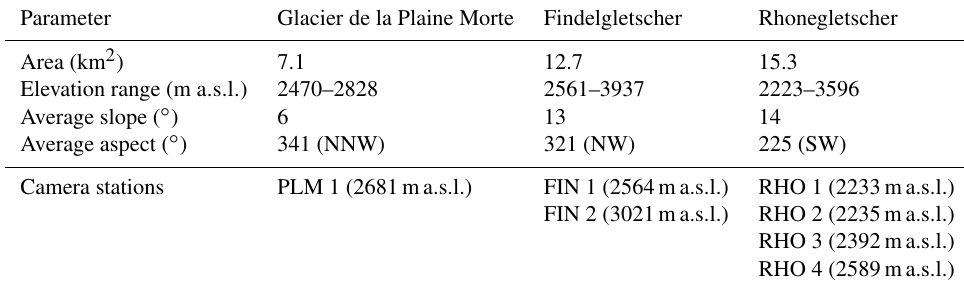
Figure 1. (a) Locations of the glaciers equipped with cameras within Switzerland and (b–d) detailed topographic maps of the glaciers with dots for cameras (red) and reference mass balance stakes (blue). Coordinates are given as Swiss coordinates (EPSG:21781). The blue glacier outlines stem from GLAMOS (Glacier Monitoring Switzerland), and background web mapping service tiles are provided by © swisstopo and © Google Maps. Table 1. Main characteristics and installed cameras for the investigated glaciers. Glacier area and elevation range refer to the year 2019 (GLAMOS, 2020), and slope and aspect have been calculated using a recent DEM (digital elevation model) (swisstopo, 2020). Parameter Glacier de la Plaine Morte